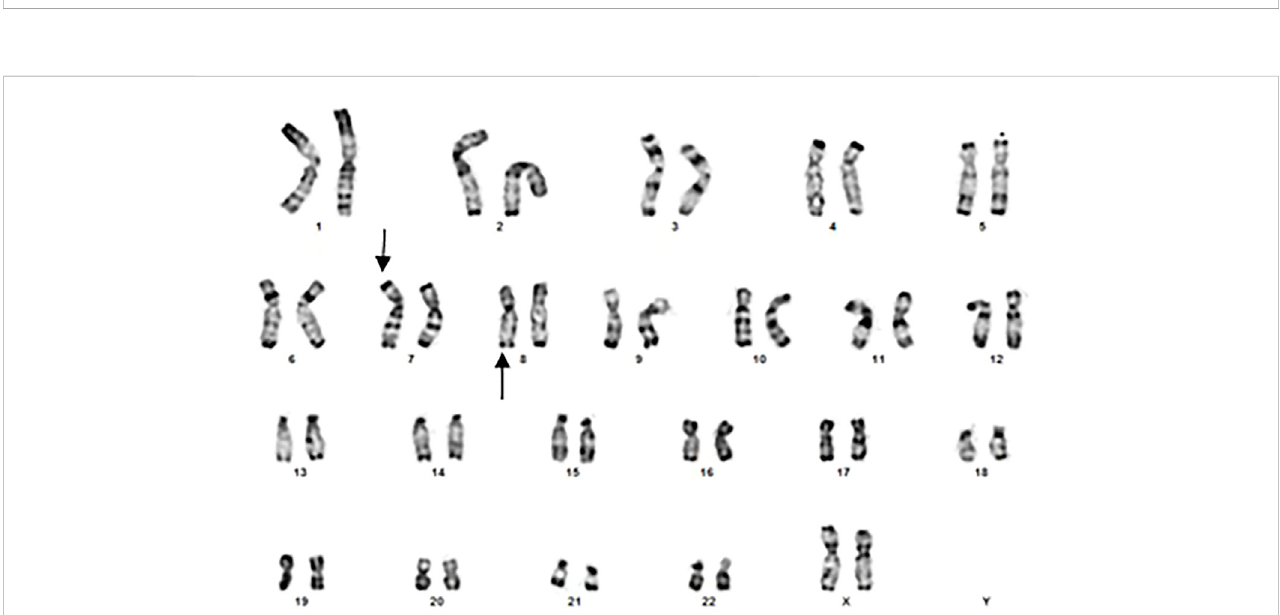
FIGURE 2 Banding cytogenetics of the mother showing a karyotype in favor of 7/8 reciprocal translocation (arroaws).